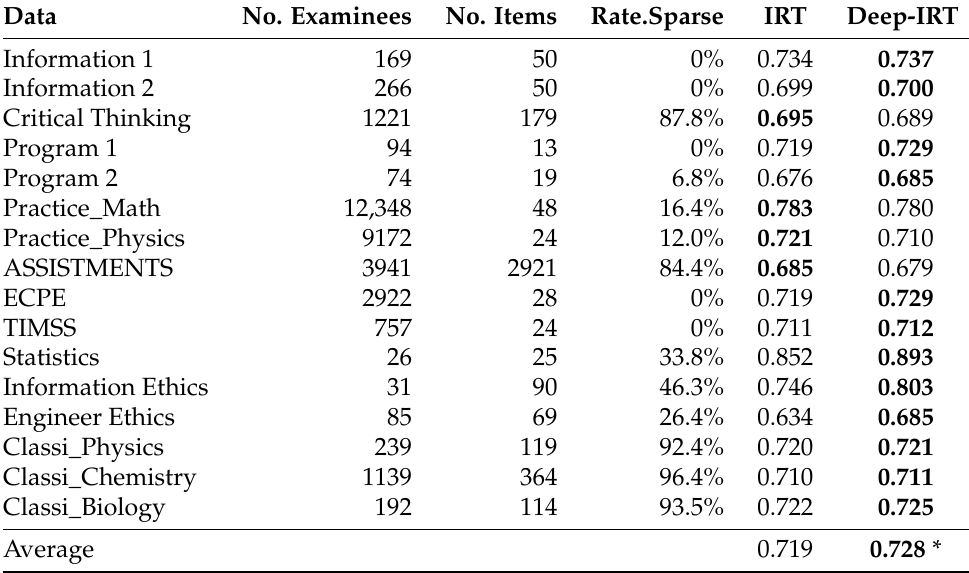
Table 5. Prediction accuracies of responses to unknown items.